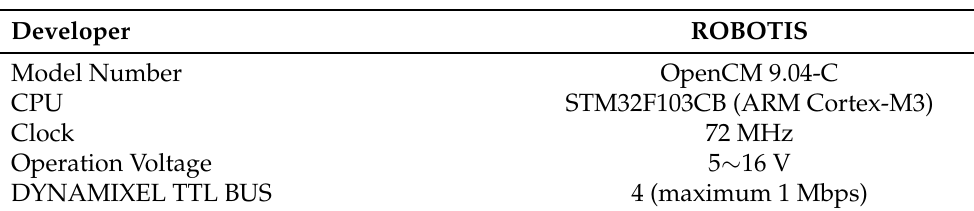
Table 3. Specifications of OpenCM